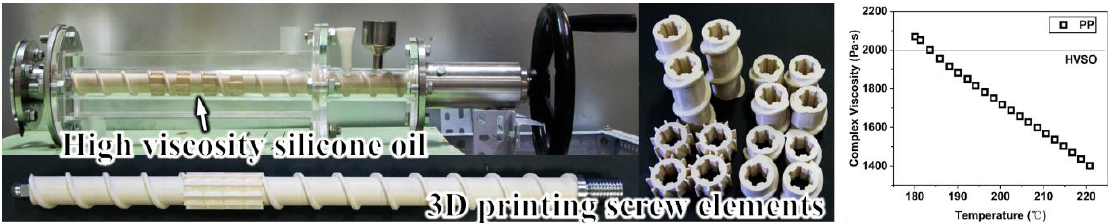
Figure 8. Visualization test stand: general view of extruder with visualization feature used in the experiments.